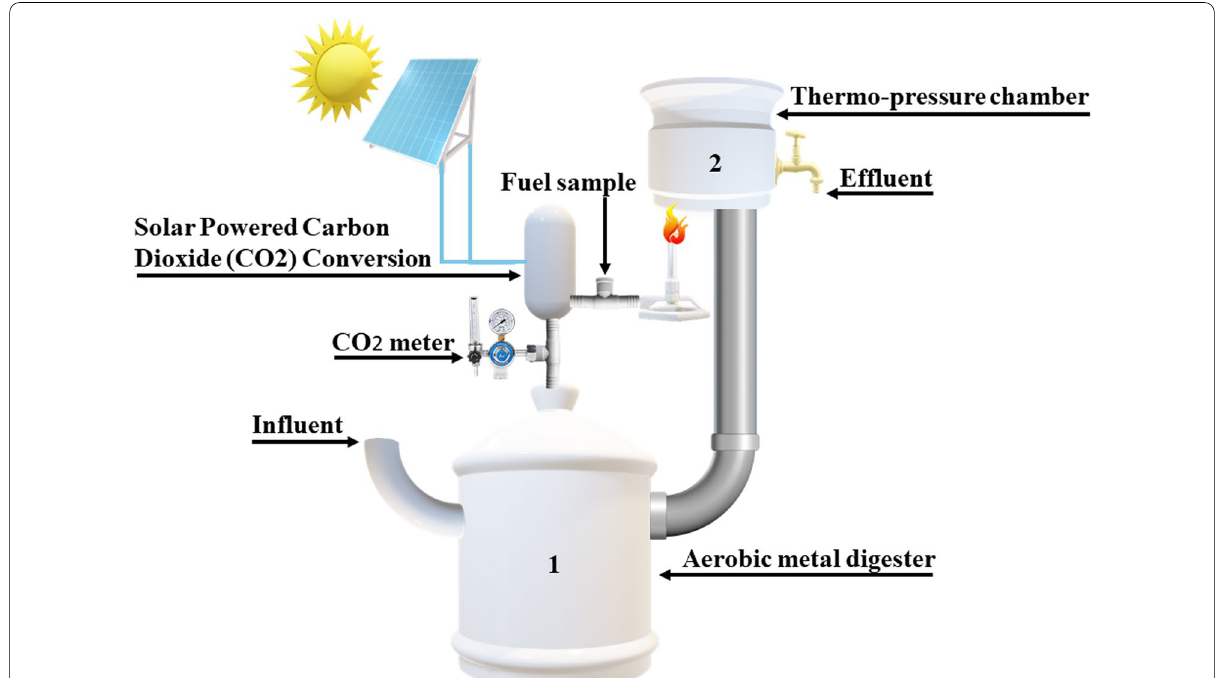
Fig. 1 Chromium laden wastewater treatment train using Pseudomonas putida APRRJVITS11; A Concept design; (1) Aerobic metal digester; (2) Thermo-pressure gDNA degradation using fuel from CO 2